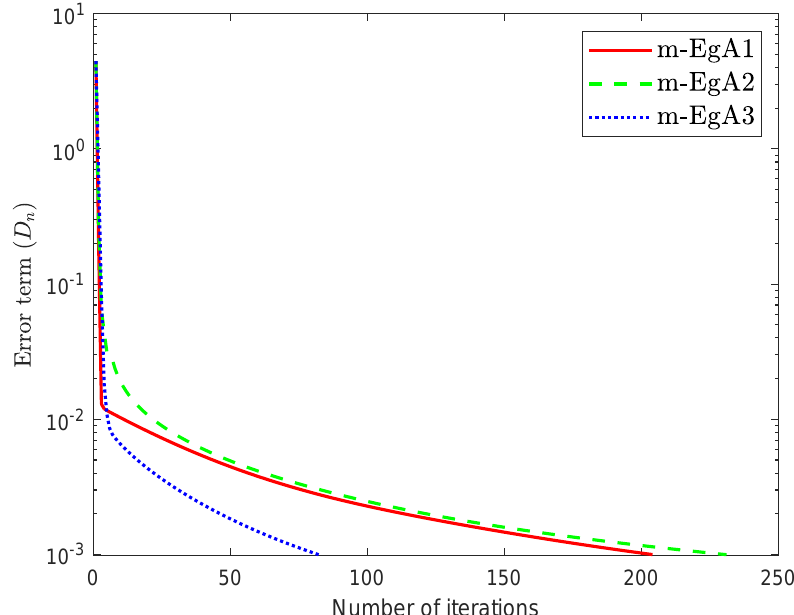
Figure 5. Numerical behaviour of Algorithm 1 compared to Algorithm 1 in [30] and Algorithm 2 in [30] for Example 1, when m = 20.